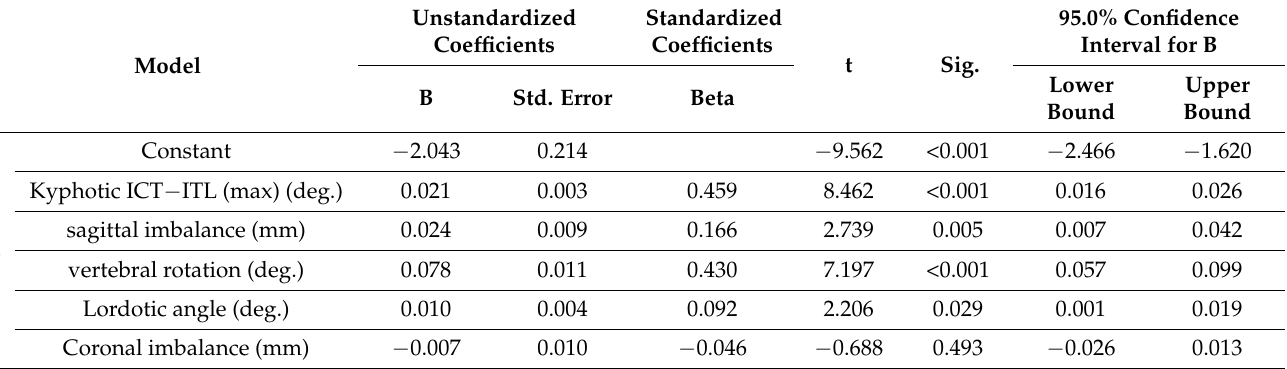
Table 4. Multiple linear regression for the fibromyalgia impact questionnaire score versus postural variables and their associated risk